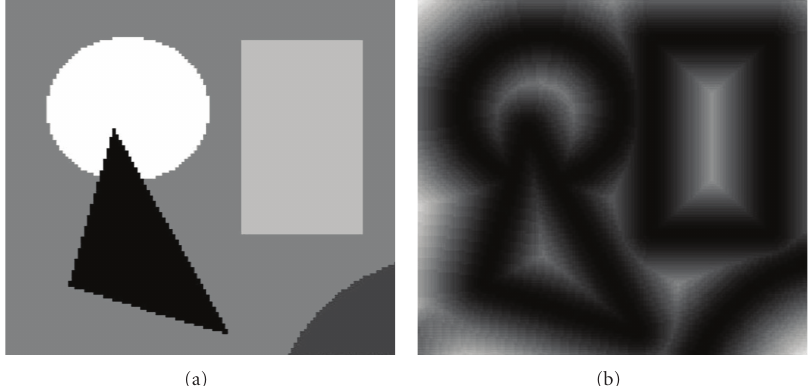
Figure 7: (a) An example noiseless image. (b) The sphere map created by the noiseless algorithm, represented as an image where each pixel x has an intensity value equivalent to the radius of its sphere S ( x ).